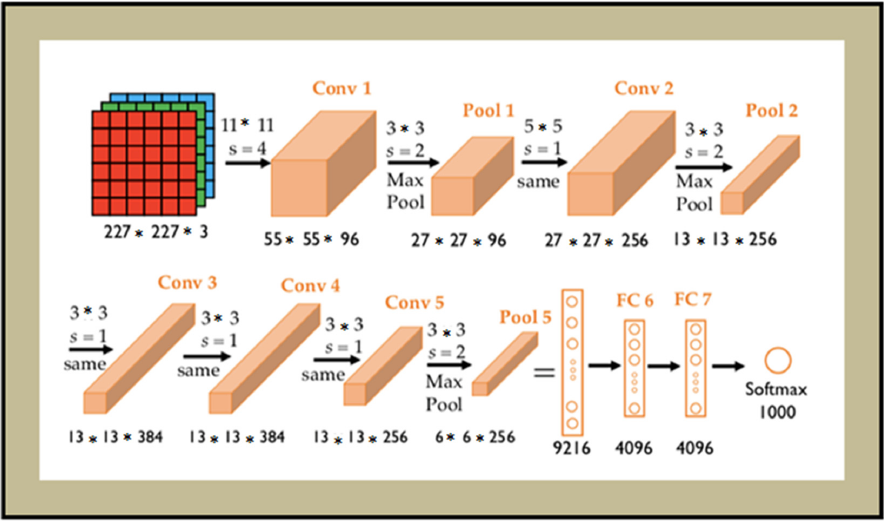
Figure 7. Five-Layer Alex-Net-based Architecture.